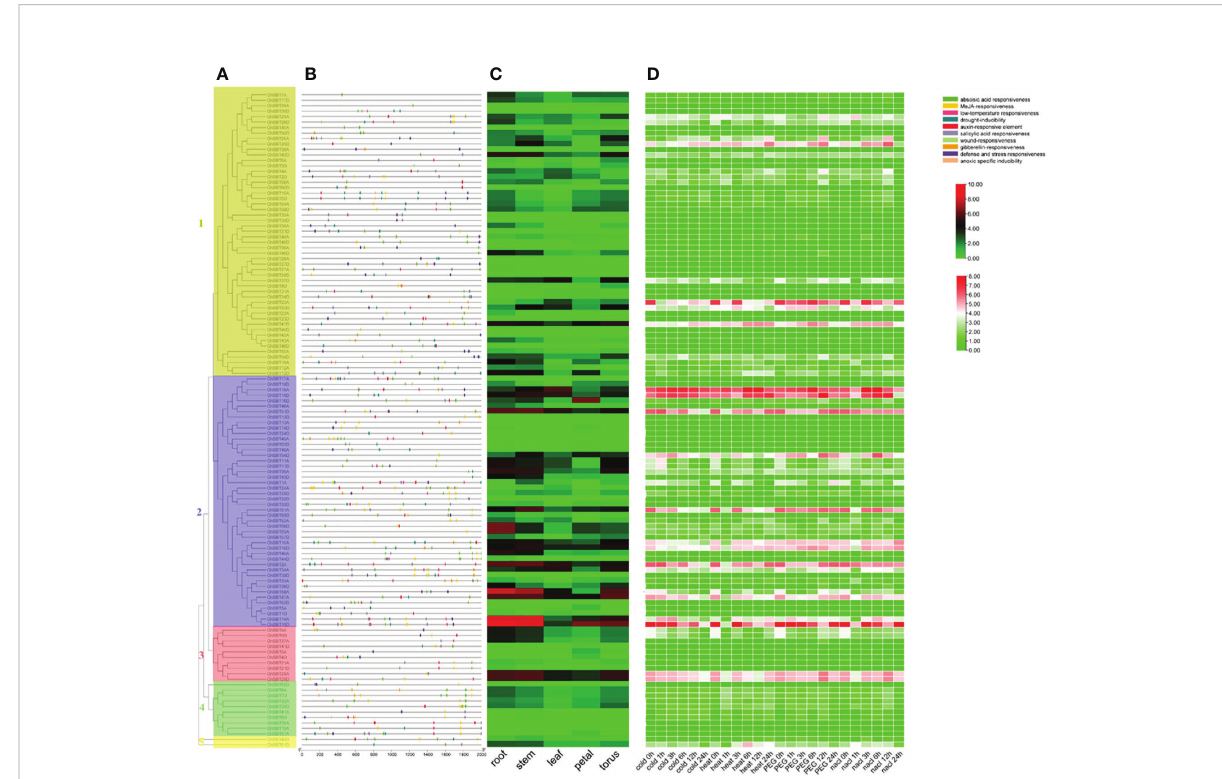
FIGURE 4 Analysis of promoters and differentially expressed genes of the GhSBT family. (A) Phylogenetic tree of GhSBT genes. (B) Cis-acting elements in the promoters of GhSBT genes. (C) The organizational expression of GhSBT genes. (D) The expression patterns of GhSBT genes under cold, hot, PEG and salt